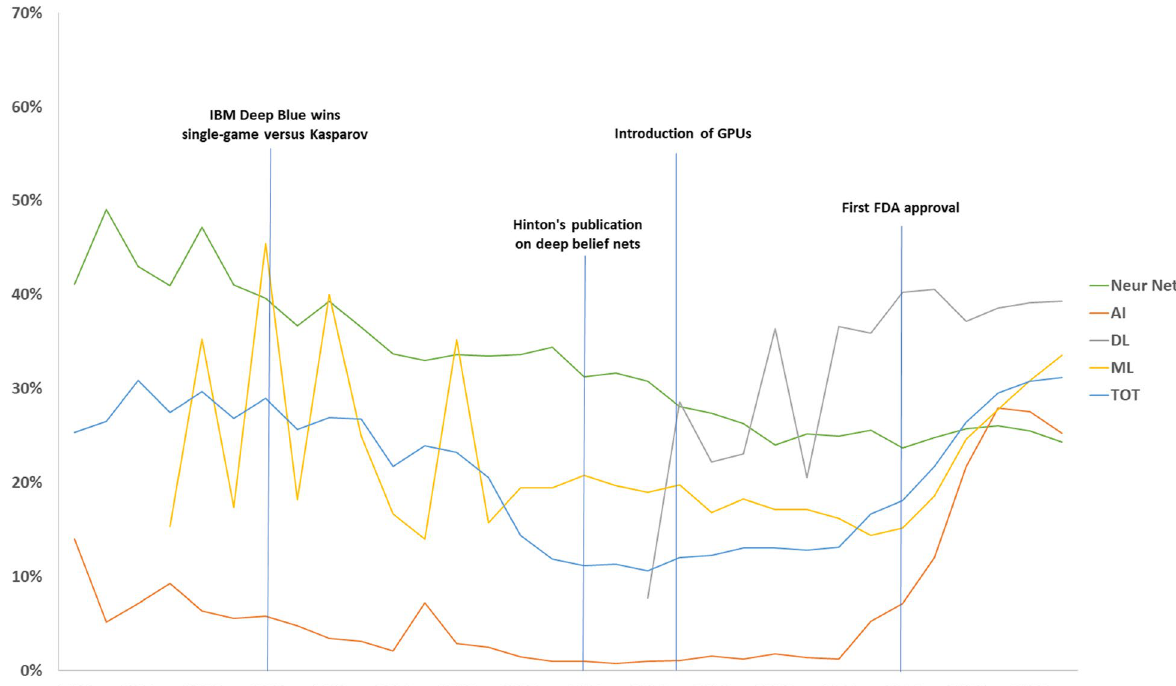
Fig. 2 Rate of articles dealing with artificial intelligence and declaring it in the title, overall and by technique. Four major milestones are shown. Neur Net Neural network, AI Artificial intelligence, DL Deep learning, FDA Food and Drug Administration, GPU Graphics processing unit, ML Machine learning, TOT